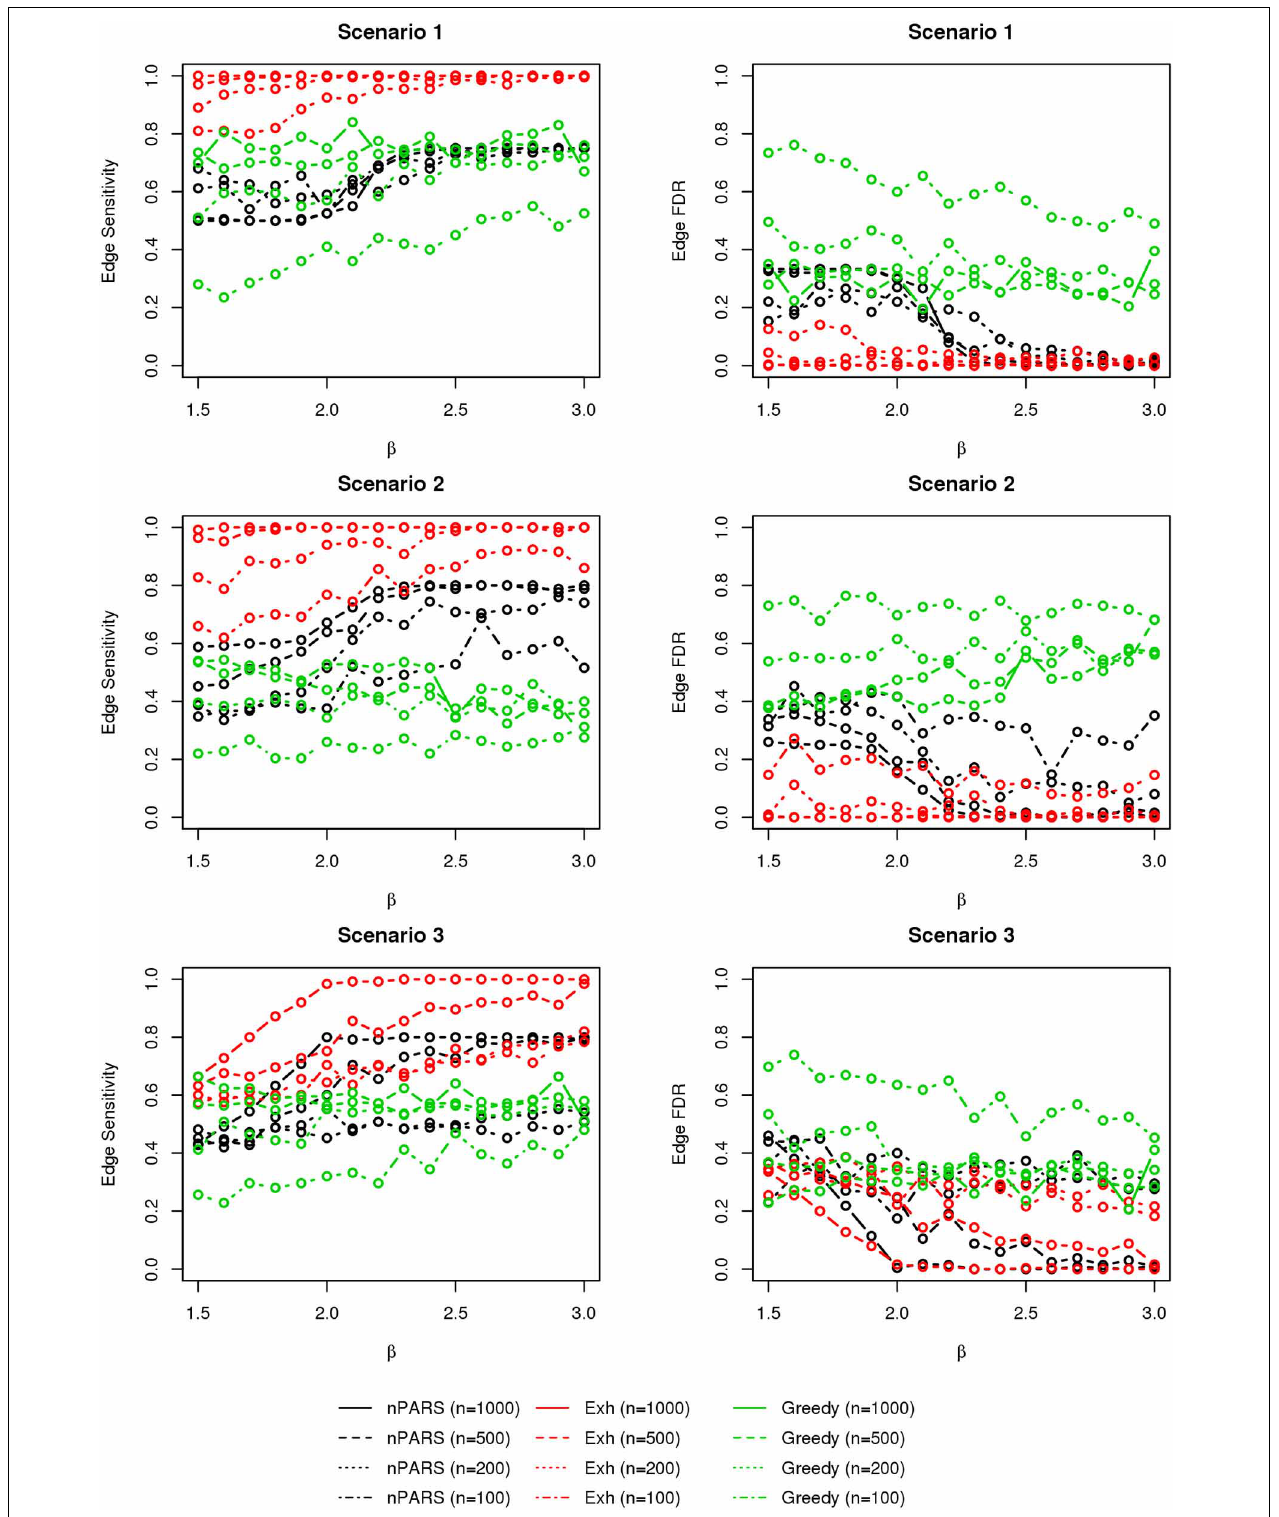
FIGURE 7 | ThesensitivityandFDRofedgecomparisonsinsimulationscenario1–3. nPARShasbetterperformancethanGreedyEintermsofedgesensitivity except in scenario 1 and 3. In scenario 1, nPARS has comparable edge sensitivity compare to GreedyE. nPARS has lower edge FDR compare to GreedyE.